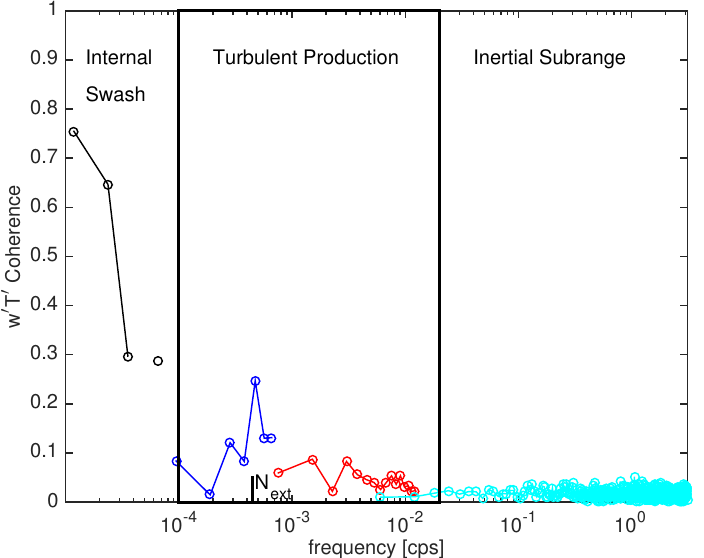
Figure 14. w (cid:48) T (cid:48) coherence. Coherence in the production regime is small, O ( 0.05 ) . Color coding is associated with increased averaging within the frequency domain. Note that coherences in the production regime in Figure 11 are larger than those for the temperature flux in this